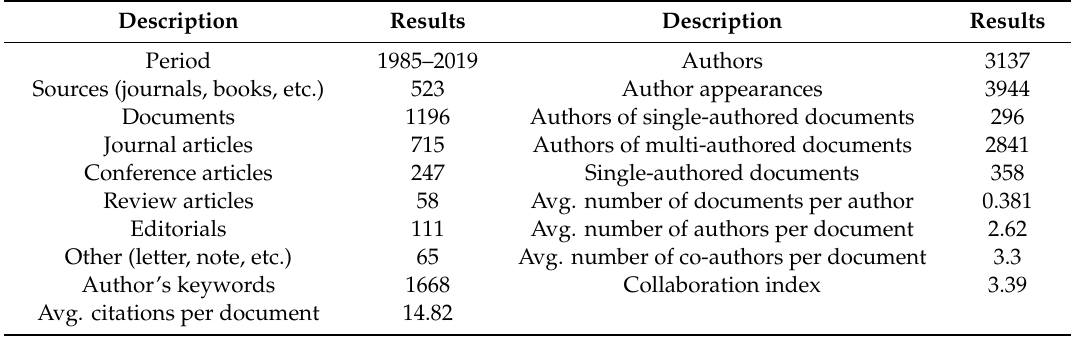
Table 1. Descriptive information of the dataset on risk communication